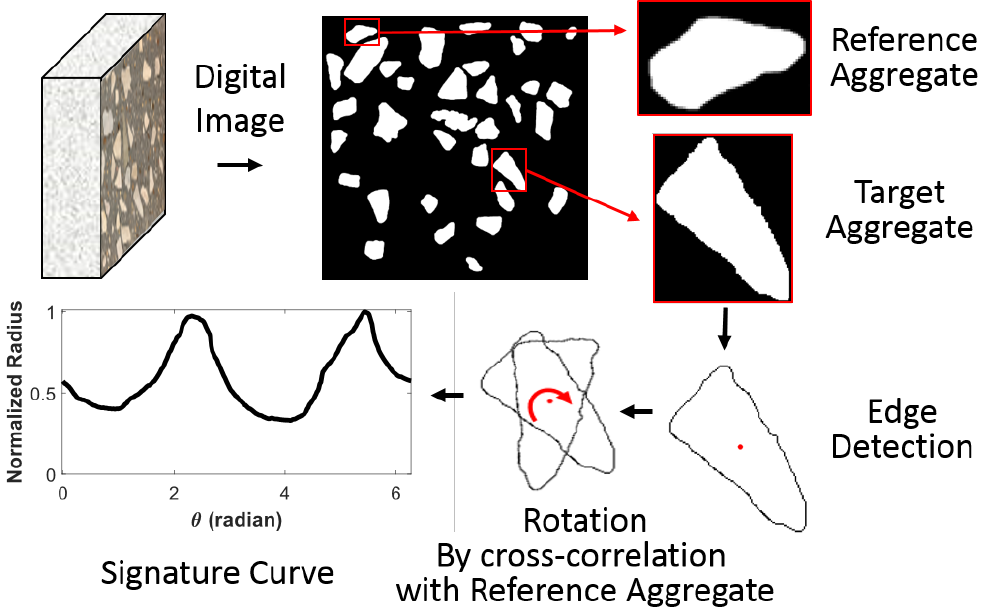
Figure 1. Digital image processing. The captured aggregate images are processed to obtain the signature curve by detecting, scaling, and rotating the edge of each recognized aggregate shape.